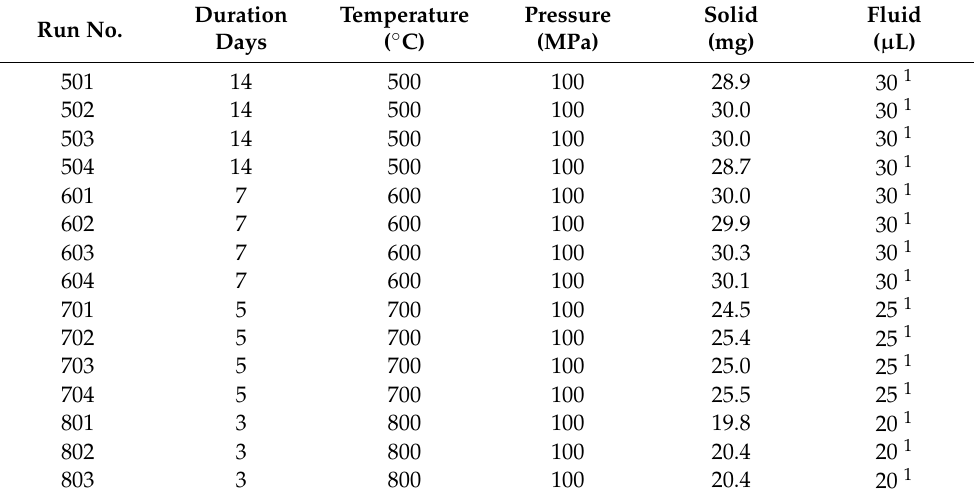
Table 1. Experimental conditions in ZnS–(Ni, Mg, Co, Fe, Mn)Cl 2 –H 2 O system. Run